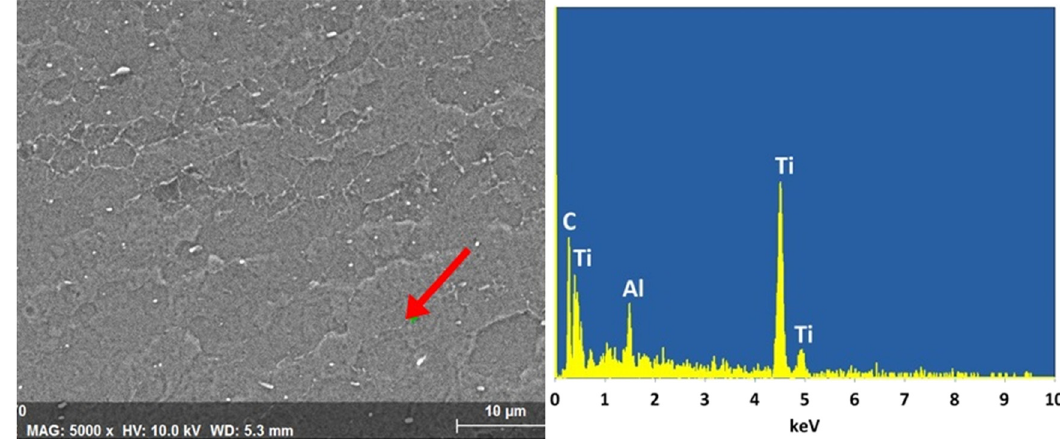
Figure 9: SEM - EDS analysis of friction stir spot welded joint: 2,000 rpm and 5 s dwell